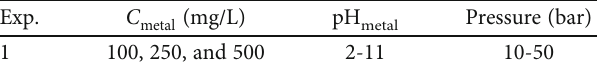
Table 1: Membrane experimental